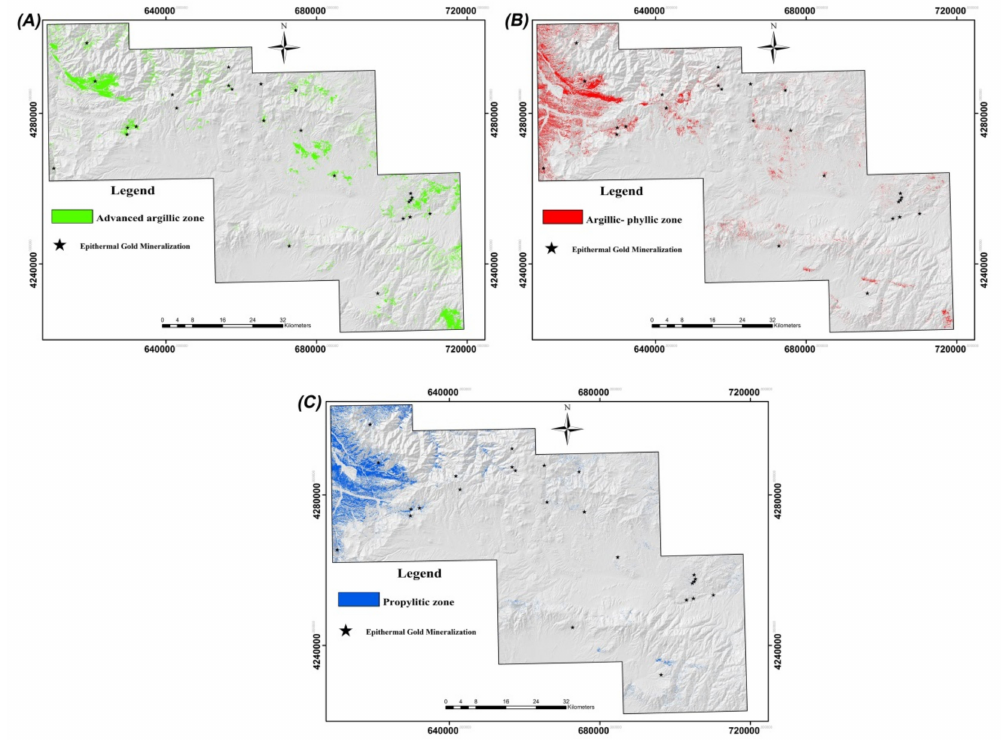
Figure 7. Spatial distribution of hydrothermal alteration zones in the study area overlaid on hill shade. ( A ) The advanced argillic alteration zone (4 / 6 band ratio image of ASTER); ( B ) the argillic-phyllic alteration zone (5 / 6 band ratio image of ASTER); ( C ) the propylitic alteration zone (5 / 8 band ratio image of